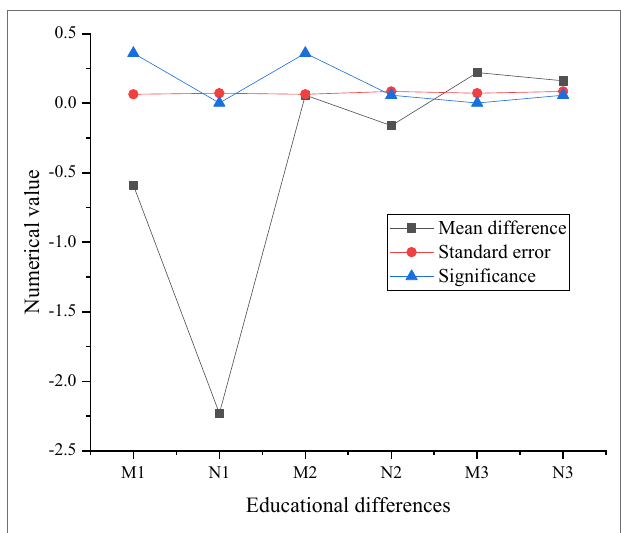
FIGURE 13 | Multiple comparison of entrepreneurs’ entrepreneurial times (in the figure, M1 and N1 represent zero entrepreneurial times, M2 and N2 represent 1–2 entrepreneurial times, and M3 and N3 represent 2 or more entrepreneurial